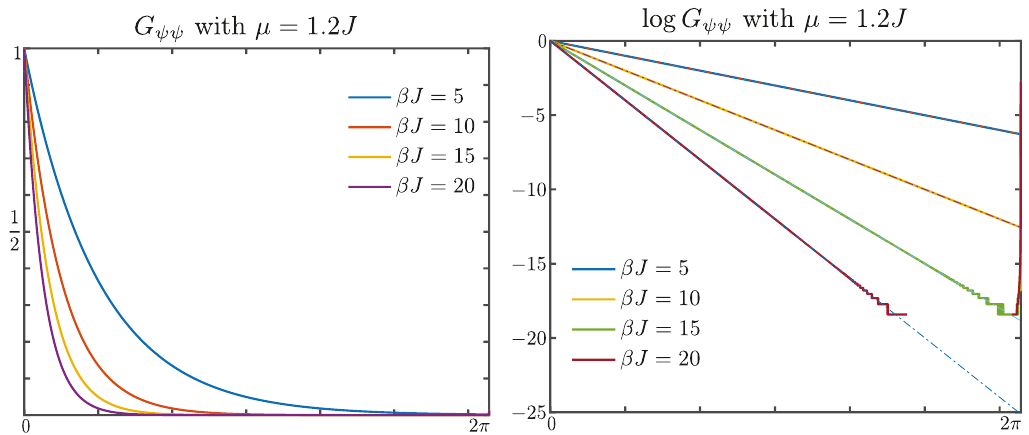
Figure 7 . Left: numerical solutions of G ψψ in the region where E > E critical . We observe exponential decay solutions. Since the solution ceases to be conformal, the infrared parameter E is no longer meaningful. The solutions depend on both βJ and µ/J. Right: log plot of G βJ, where dashed lines are linear fits. We observe that the exponent is linear in µ .